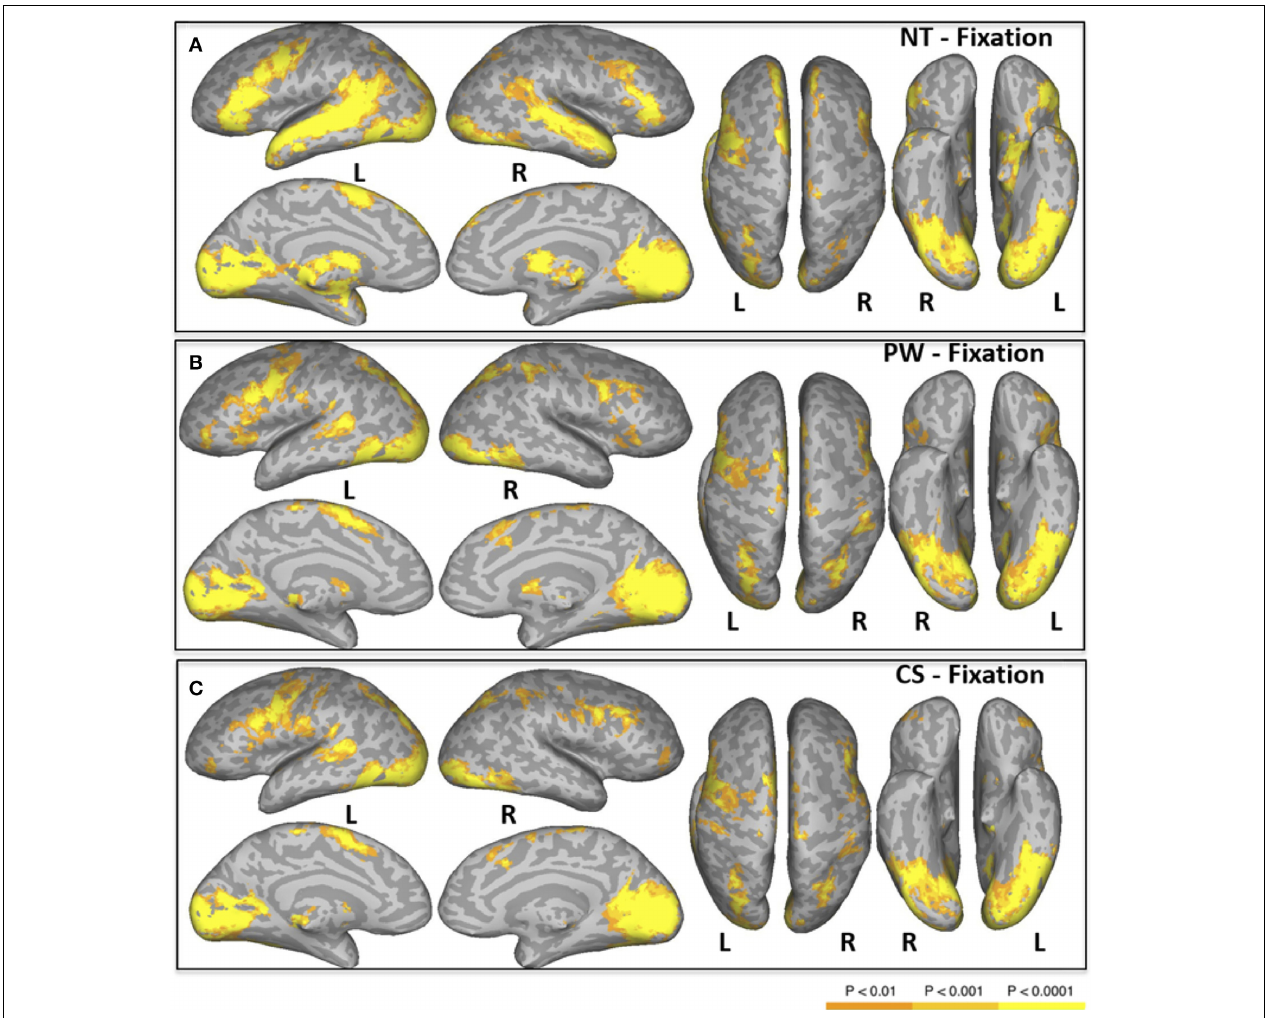
FIGURE 1 | Areas of significant activation in a whole-brain analysis of natural reading of normal text [NT condition, (A)], and “reading” pseudowords [PW condition, (B)] and consonant strings [CS condition, (C)]. L, Left Hemisphere; R, Right Hemisphere.